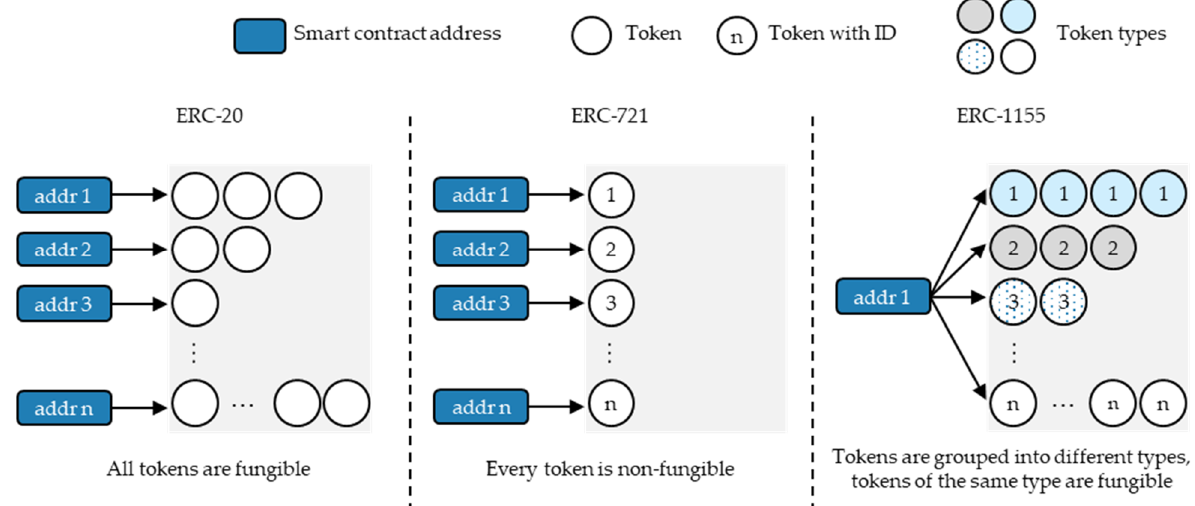
Figure 1 . Overview of Ethereum token standards and their functionality (adapted from [48 . ]) Figure 1. Overview of Ethereum token standards and their functionality (adapted from